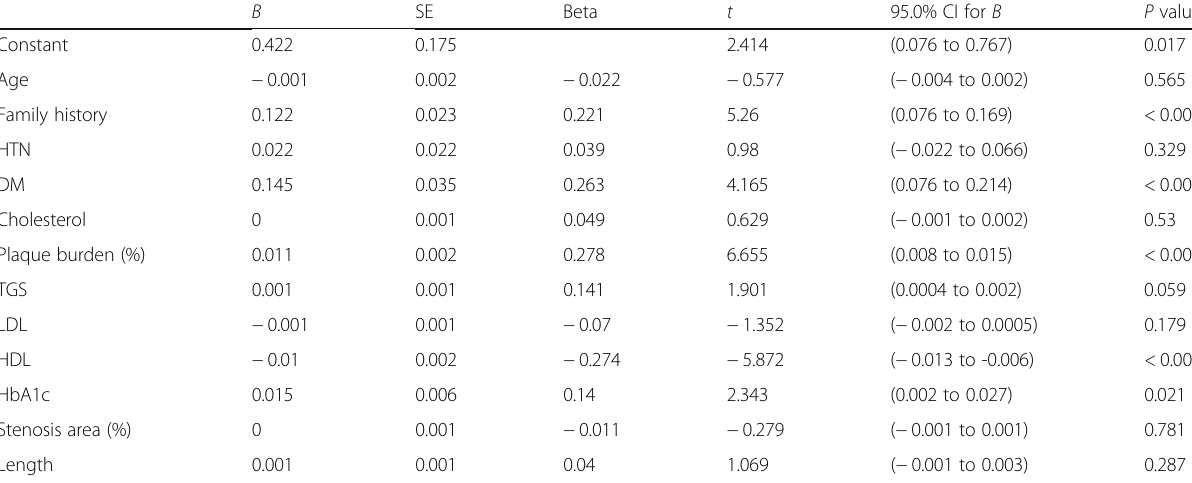
Table 2 Linear regression analysis for remodeling index (RI)